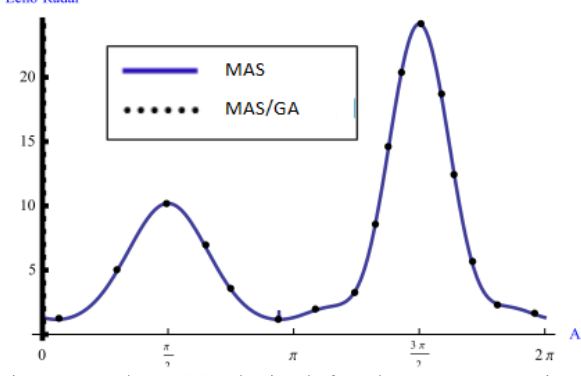
Figure 6: The RCS obtained for the same error in boundary conditions with Genetic Algorithm